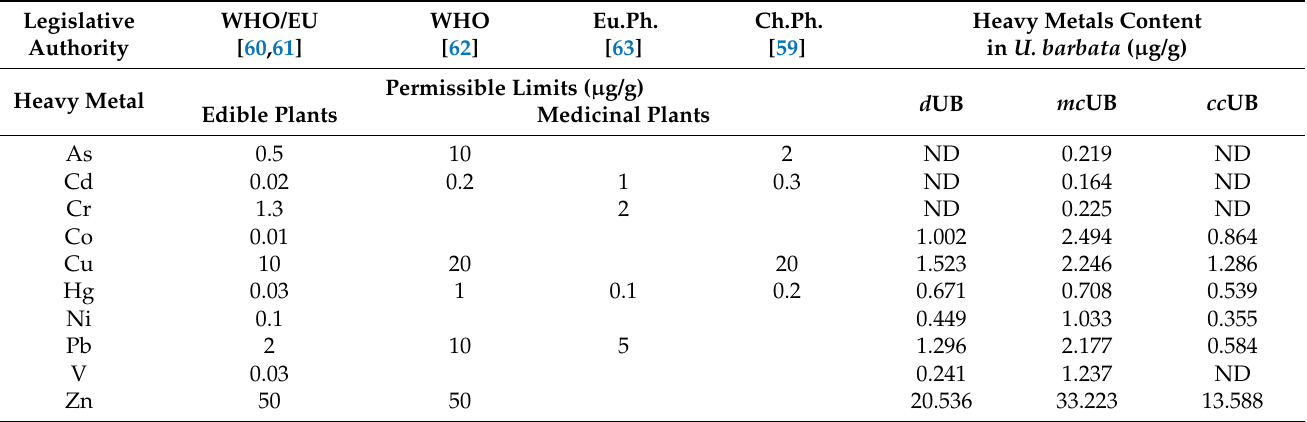
Table 4. Permissible limits for heavy metals in edible and medicinal plants and their content in